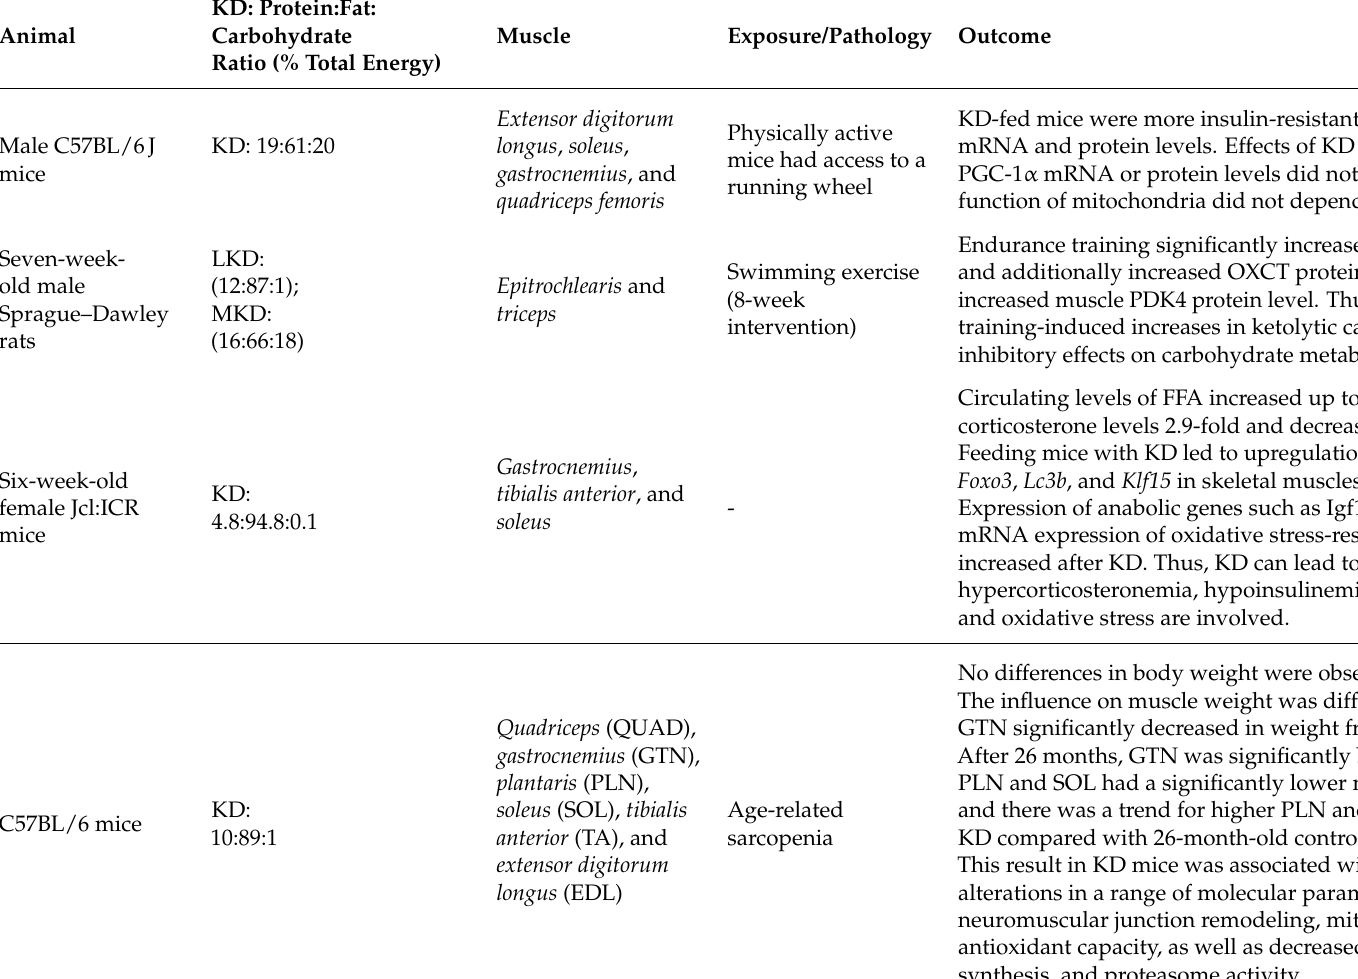
Table 1. Effects of KD on skeletal